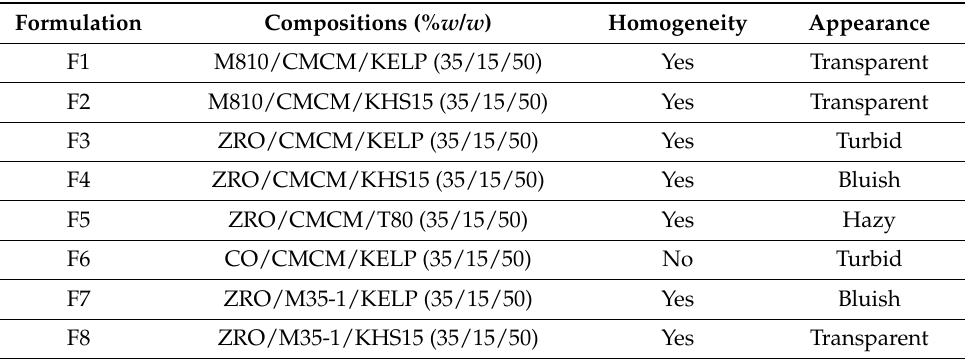
Table 2. Performance of lipid-based formulations on the basis of homogeneity, appearance, and self-emulsification capability.